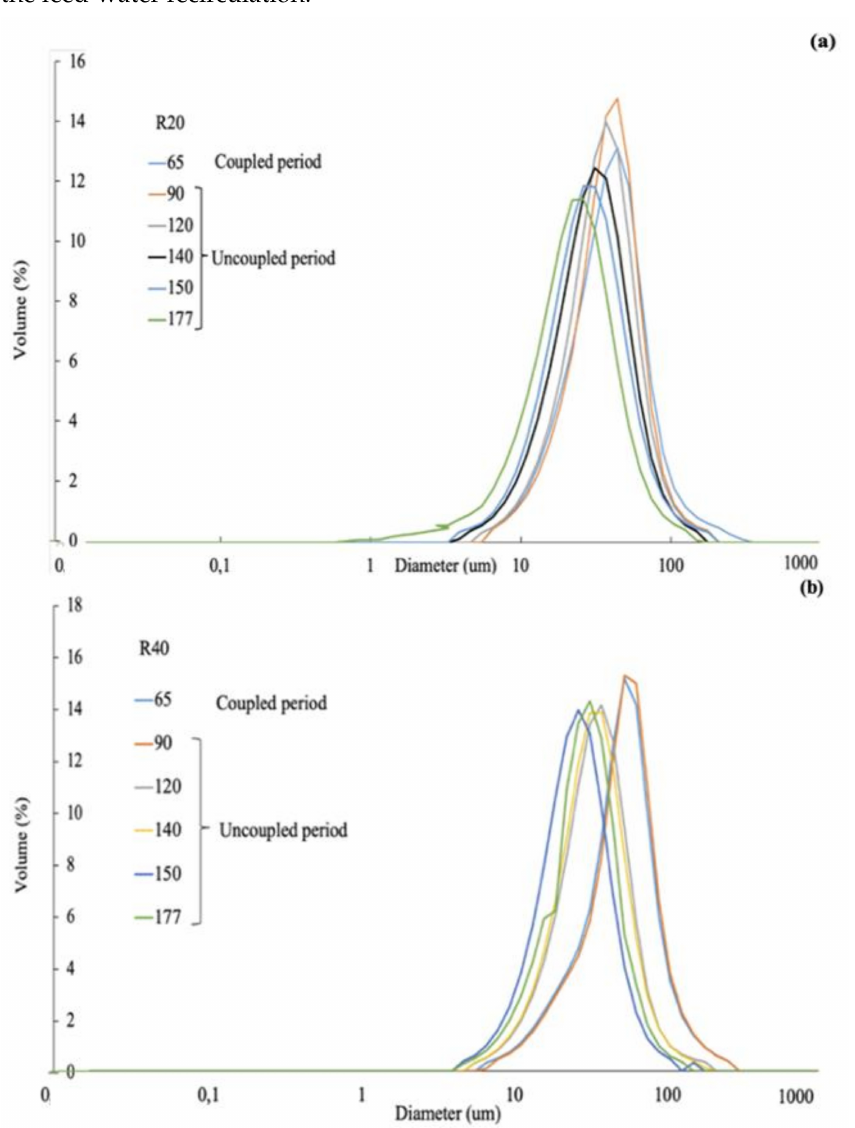
Figure 3. Particle size distribution (PSD) over operational time for ( a ) R20, and ( b ) R40 reactors over